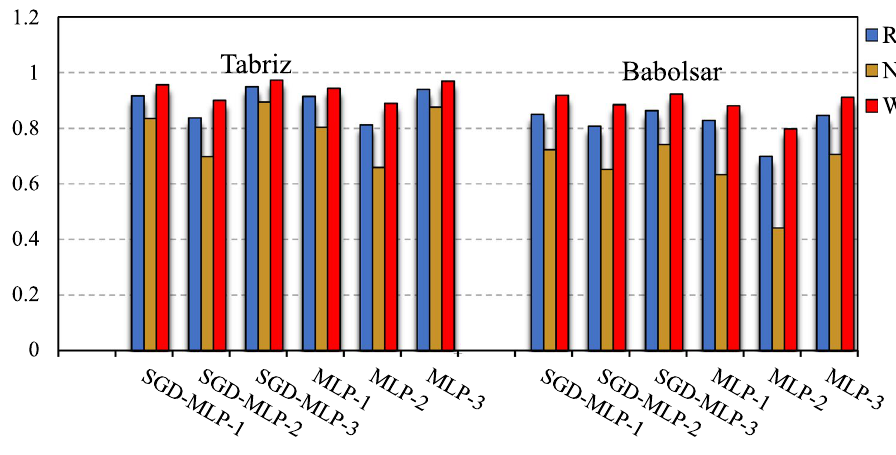
Fig. 3 Three-dimensional bar graphs of the statistical parameters Tabriz and Babolsar station